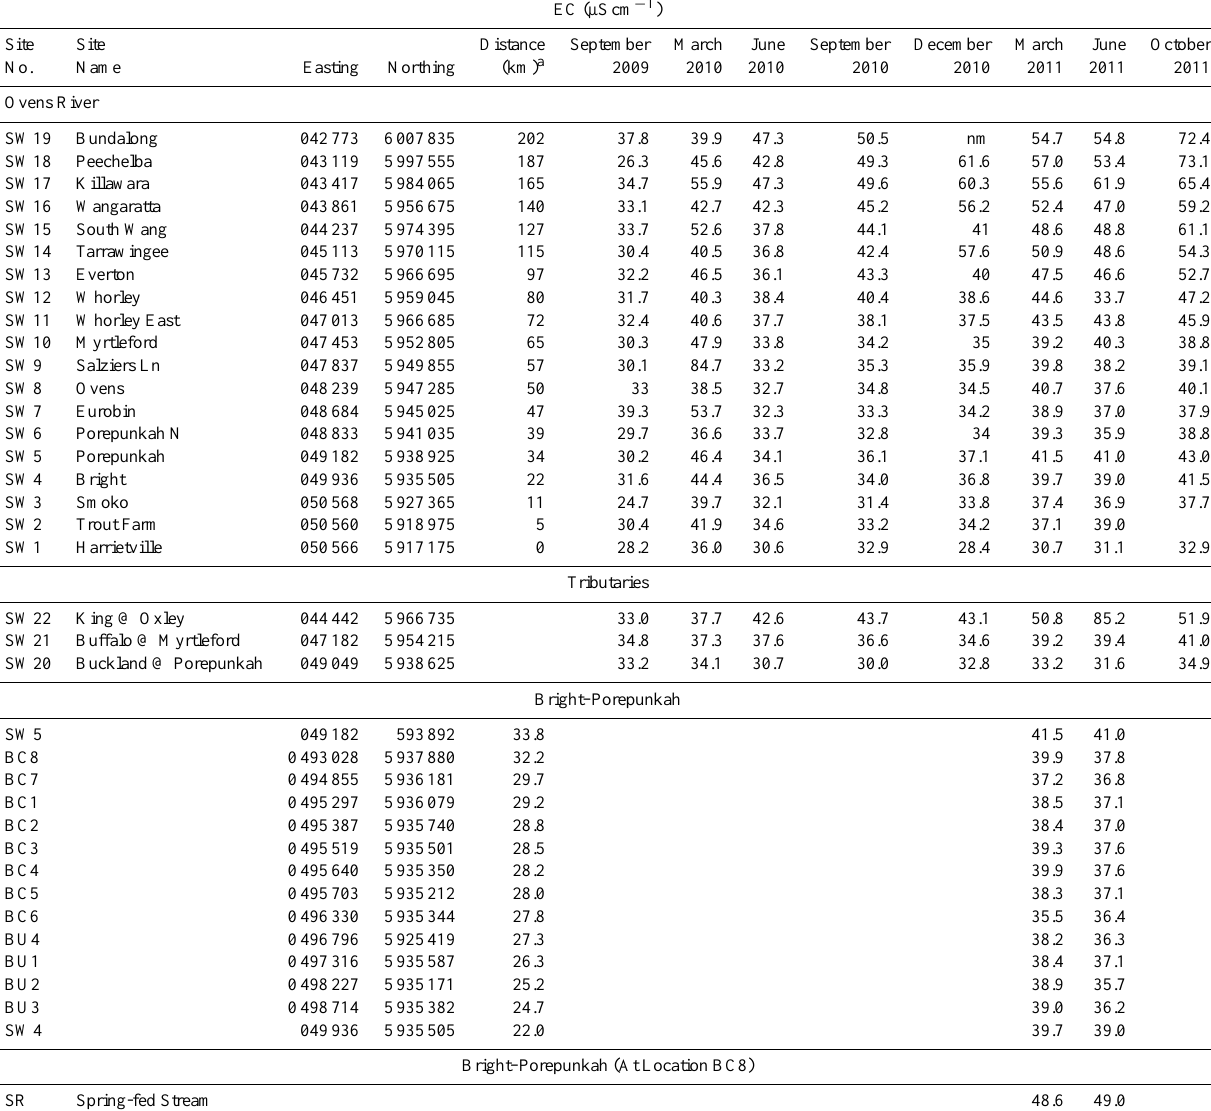
Table 1. EC values of the Ovens River. Notes: nm – not measured; a – distance from the uppermost sampling site, Harrietville. EC (µScm − 1